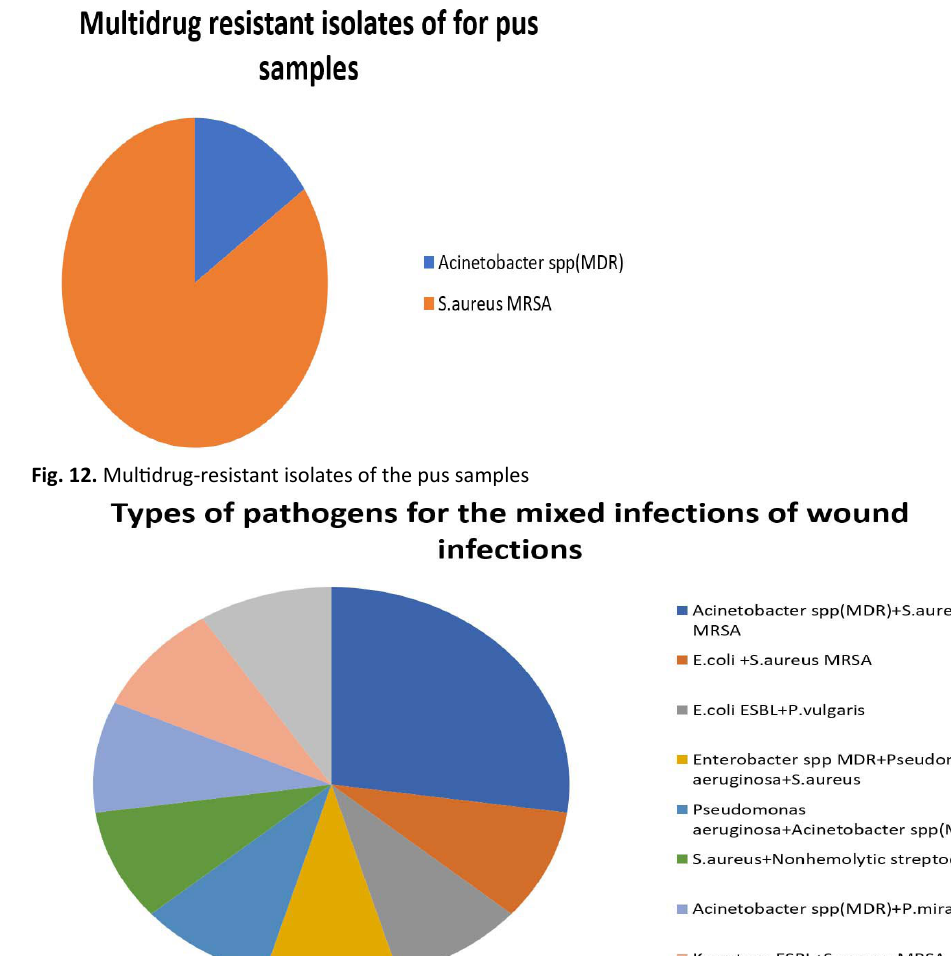
Fig. 11. High drug resistant and MDR isolates of the pus samples